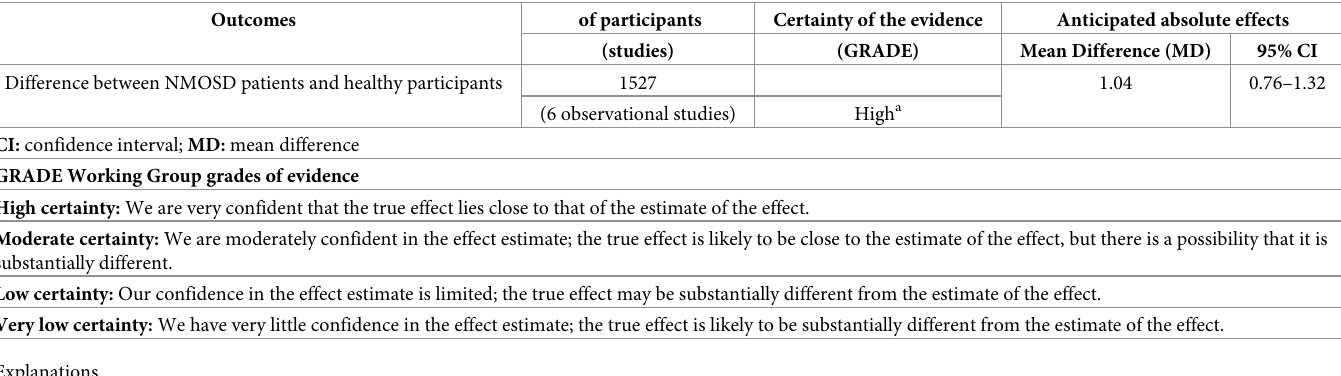
Table 3. GRADE summary of findings between NMOSD patients and healthy